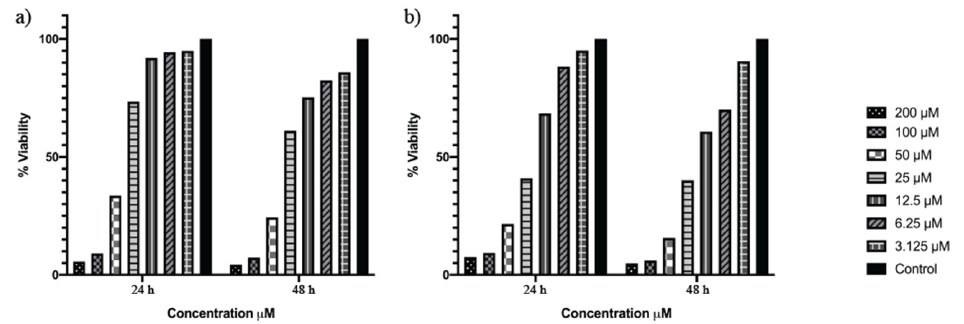
Figure 6. PANC ‐ 1 cells were treated with increasing concentrations of α ‐ aminophosphonate 1 ( a ) and silver complex 3 ( b ) for 24 and 48 h. The viability was determined by metabolic rate using the MTT assay. Absorbance values were measured at 570 nm and normalized against untreated cells.